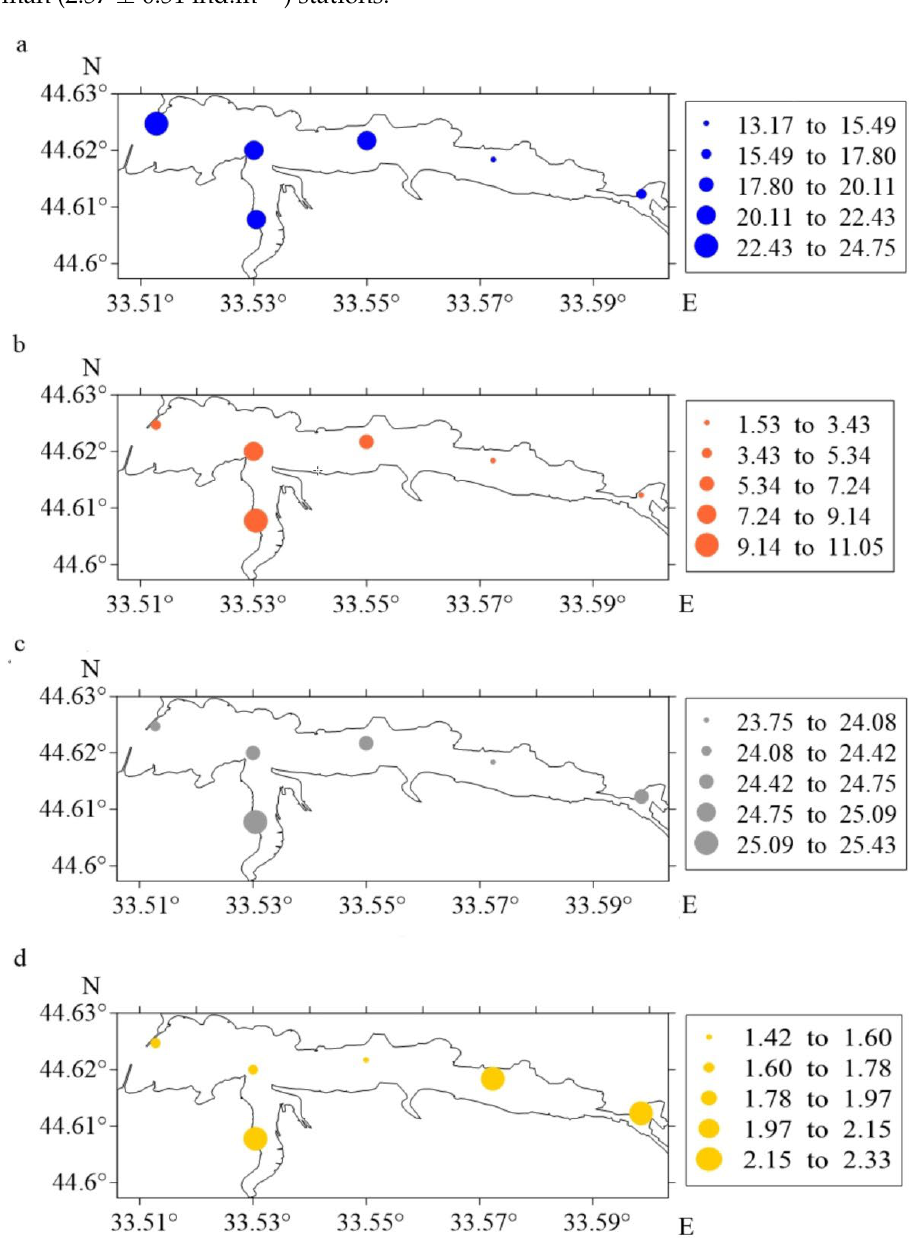
Figure 3. The number of eggs (( a ), ind. m − 2 ), larvae (( b ), ind. m − 2 ), as well as the water temperature (( c ), °C) and the strength of the wind (( d ), points) in the Sevastopol Bay in the summer of 2012–2021. Table 1. Average (±SD) values for ichthyoplankton abundance and hydrometeorological character- istics and their standard deviations in the Sevastopol Bay in the summer of 2012–2021.